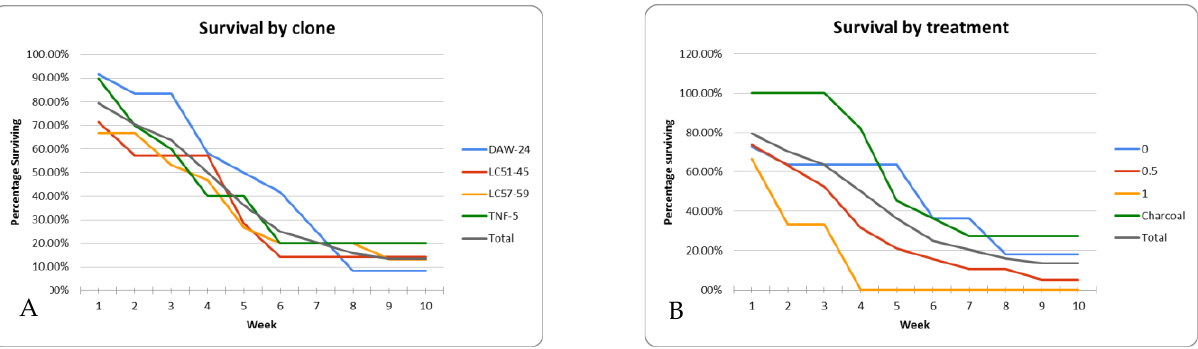
Average values within the 8 week data column are statistically different by the multiple-range test at p < 0.01 as indicated by different letters.